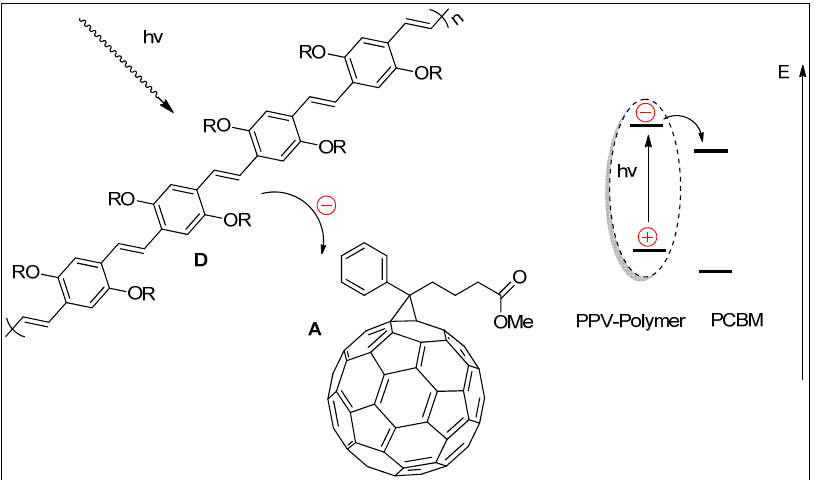
Figure 11. Illustration of the main process of photoinduced electron transfer from the donor (RO- PPV) to the acceptor (PCBM) as well as energy-level diagram of the working process for a D–A heterojunction solar